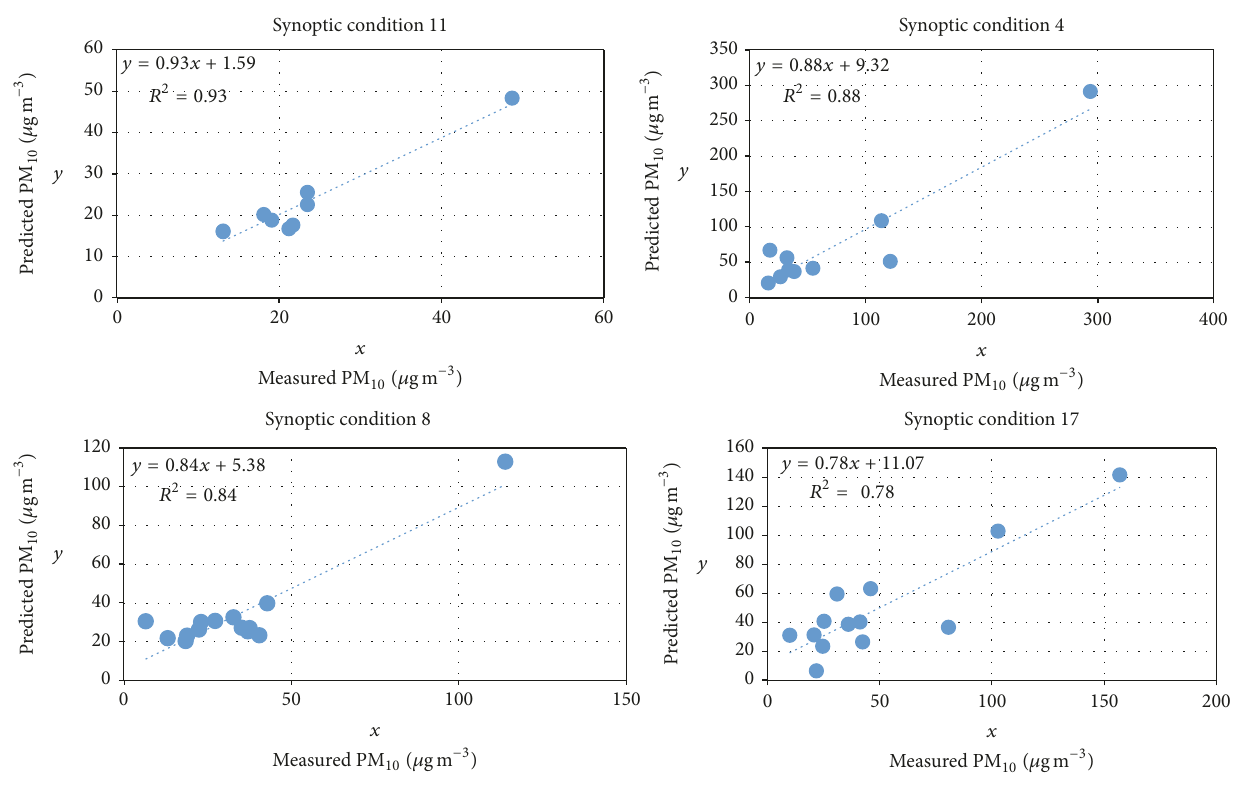
Figure 14: Scatterplots between measured and predicted PM 10 values for the four synoptic conditions with the highest coefficient of determination. Table 2: Contingency table used for calculating the statistical